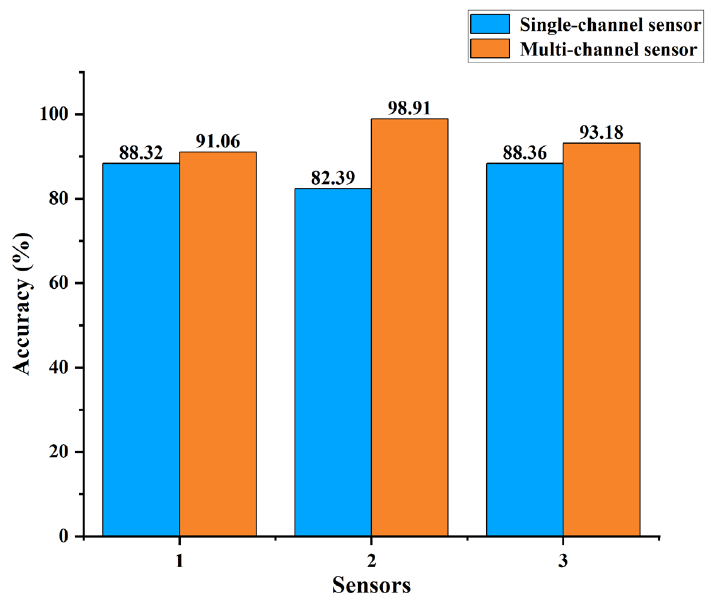
Figure 21. Accuracy comparison of sensor single-channel and sensor multi-channel before fusion.